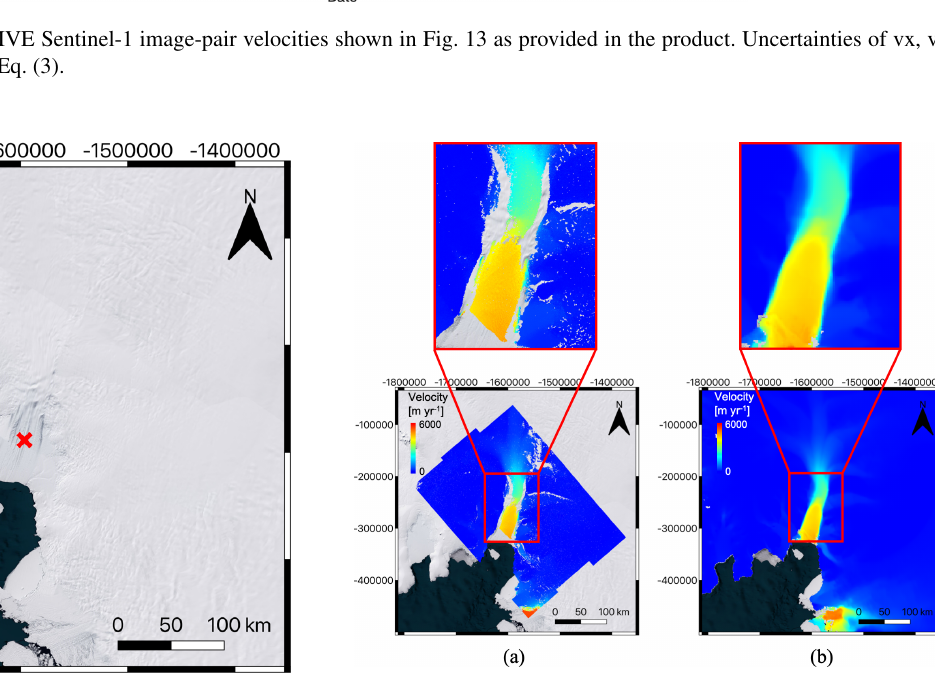
Figure 15. Optical image of the Pine Island Glacier in the Antarc- tic, where the red cross marks the location of the fast-moving glacier outlet that was used for the validation exercise. Background: © Mi- crosoft Bing Maps 2022.